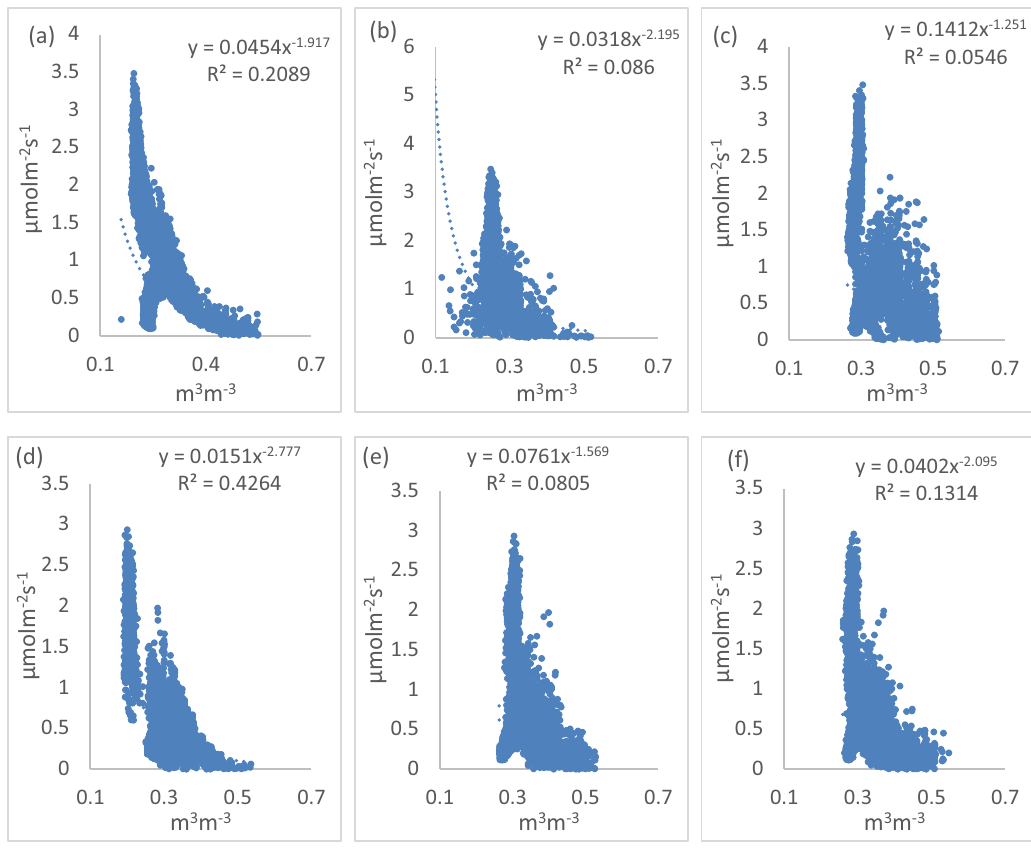
Figure 5. Correlations between soil surface CO 2 efflux and soil moisture (a) at 5 cm depth in the TC treatment (b) at 10 cm depth in the TC treatment (c) at 15 cm depth in the TC treatment (d) at 5 cm depth in the MC treatment (e) at 10 cm depth in the MC treatment (f) at 15cm depth in the MC treatment.